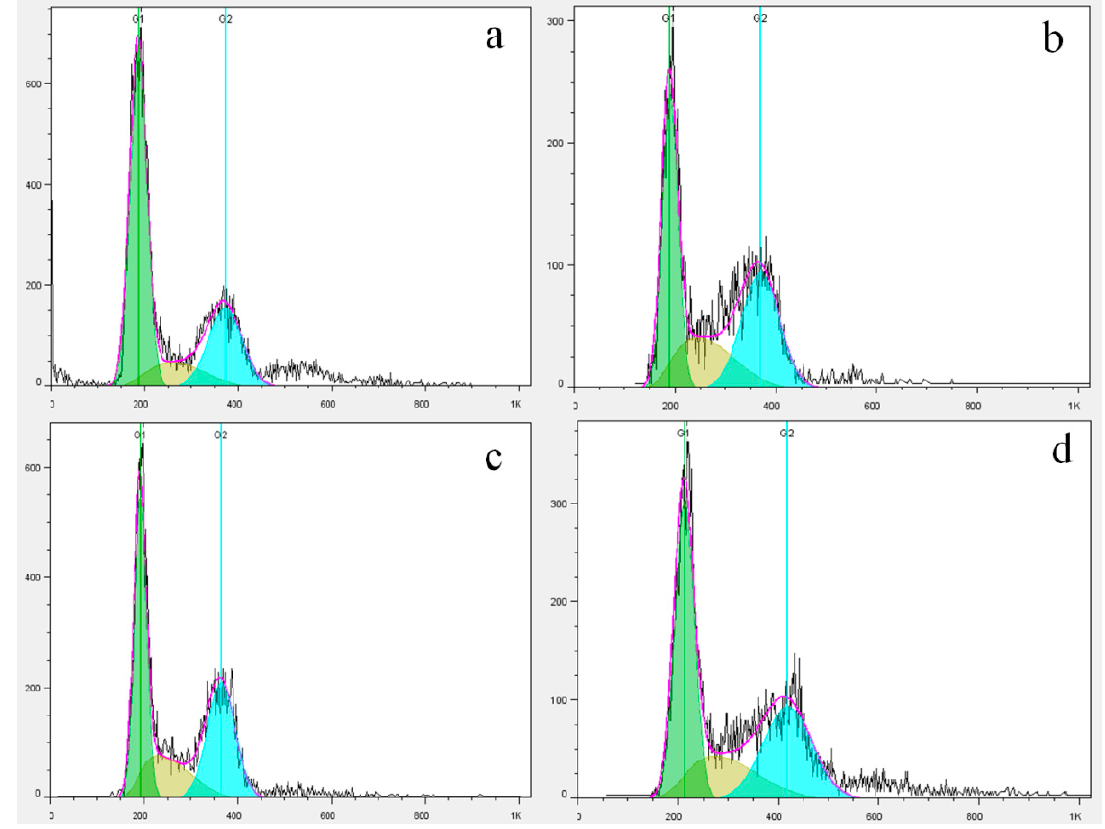
Figure 8. Cell cycle distribution of PC12 in ( a ) CK; ( b ) damage group and ( c , d ) sample group were analyzed through flow cytometry ( ■ G1, ■ G2, ■ S). The “K” could not changed to lowercase “k” in the X-axis, because the “K” automatically generated in software.